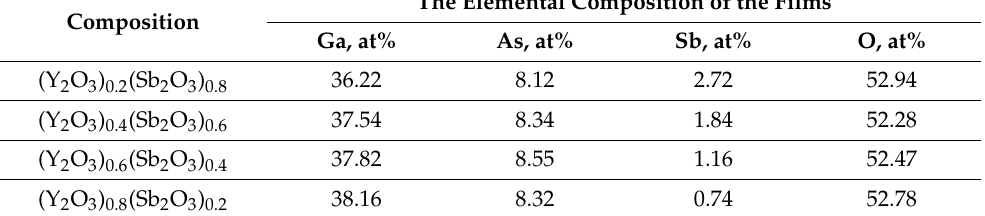
Table 1. The elemental composition of films on GaAs obtained under the influence of Y 2 O 3 + Sb 2 O 3 compositions.